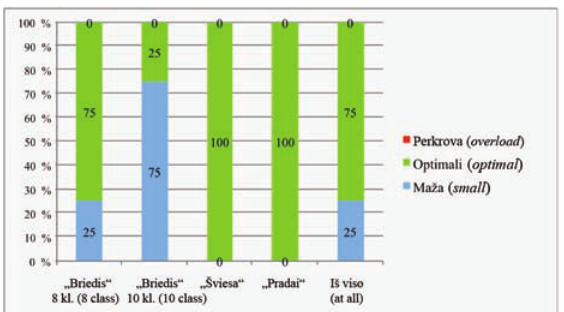
Fig. 7 . Informative strain (capacity) in the analysed economic maps of scholastic geographical